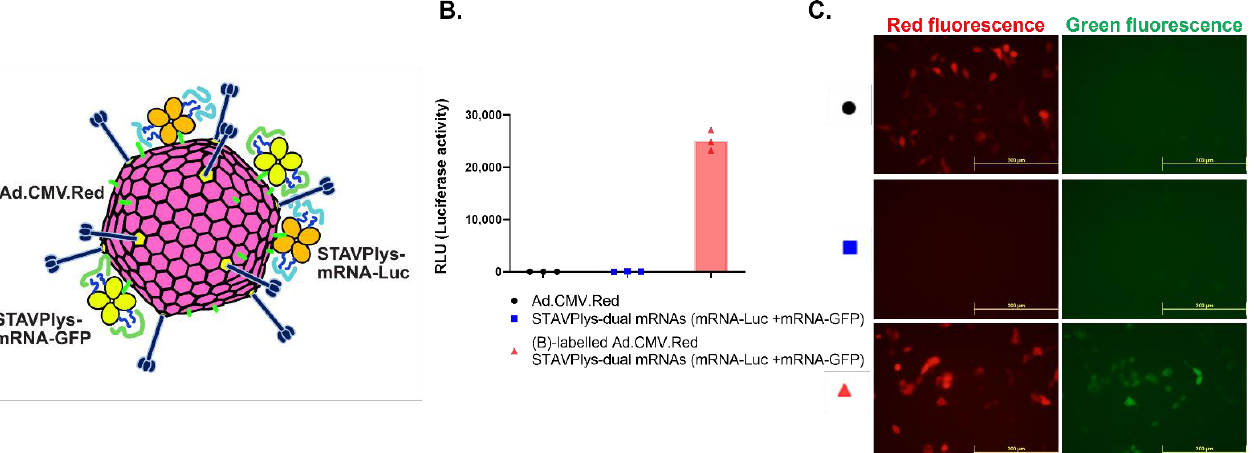
Figure 4. Co-delivery of multiple mRNAs via chimeric nanosystem. To explore the possibility of the simultaneous delivery of two mRNAs (mRNA encoding luciferase and mRNA encoding GFP, 0.375 ug each) via our piggyback approach, in vitro gene transfer was evaluated and confirmed with both gene signals detected (Luciferase activity and GFP expression) in 293 cells. The schema for nanosystem-based piggyback strategy for two mRNAs is shown at the left ( A ) with data in middle [Luciferase activity] ( B ) and in right [Green fluorescence] ( C ).